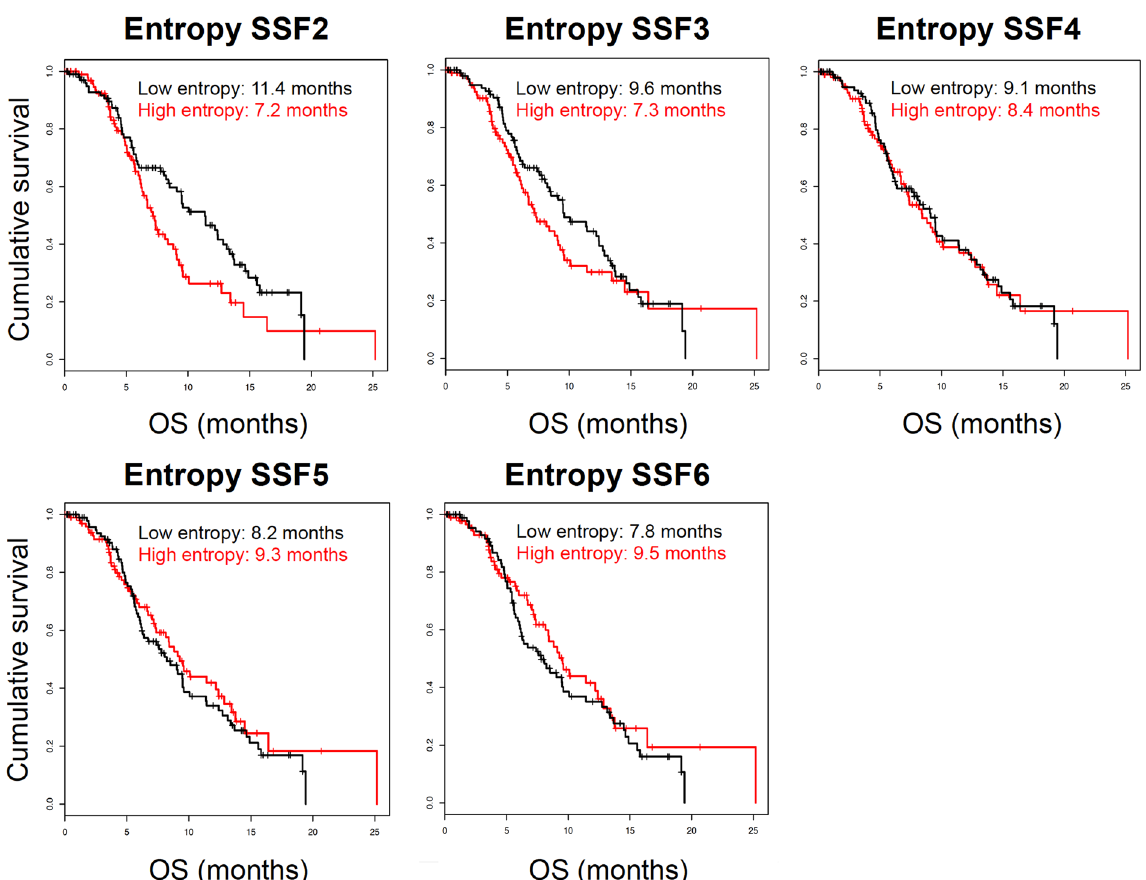
Figure 5. Association between metastases’ entropy and patients’ overall survival. Kaplan Meier estimates show the cumulative overall survival in patients with low and high entropy (sample median entropy was used to define the high- and low- groups) according to different spatial scale filters (SSF2-6). The association between high entropy and OS changes across SSFs: this illustrates the problem of false positives due to type I error and publication bias retaining only positive